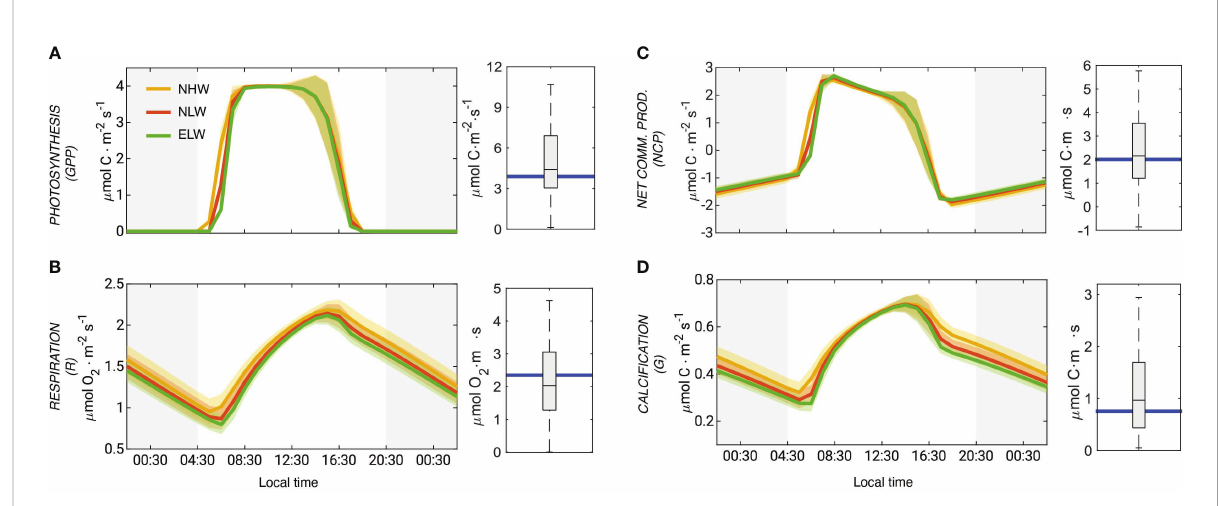
FIGURE 5 Model simulated coral metabolism and evaluation with observations: Mean diel cycle of net photosynthesis (GPP) (A) , respiration (R) (B) , net community production (NCP) (C) and coral calci fi cation (G) (D) averaged over the entire domain. The comparison of model simulated mid-day rates with observations are given on the right side of each panel. The rates for the different wave regimes are indicated with different colors (NHW: yellow; NLW: red; ELW: green). The shadings indicate the variability (i.e., one standard deviation). The blue line shows the annual mean rates, computed from the weighted averages simulated for the three wave regimes. All rates are given as planar fl ux densities. The data are from Carpenter (2015) and other sources (see Supplementary